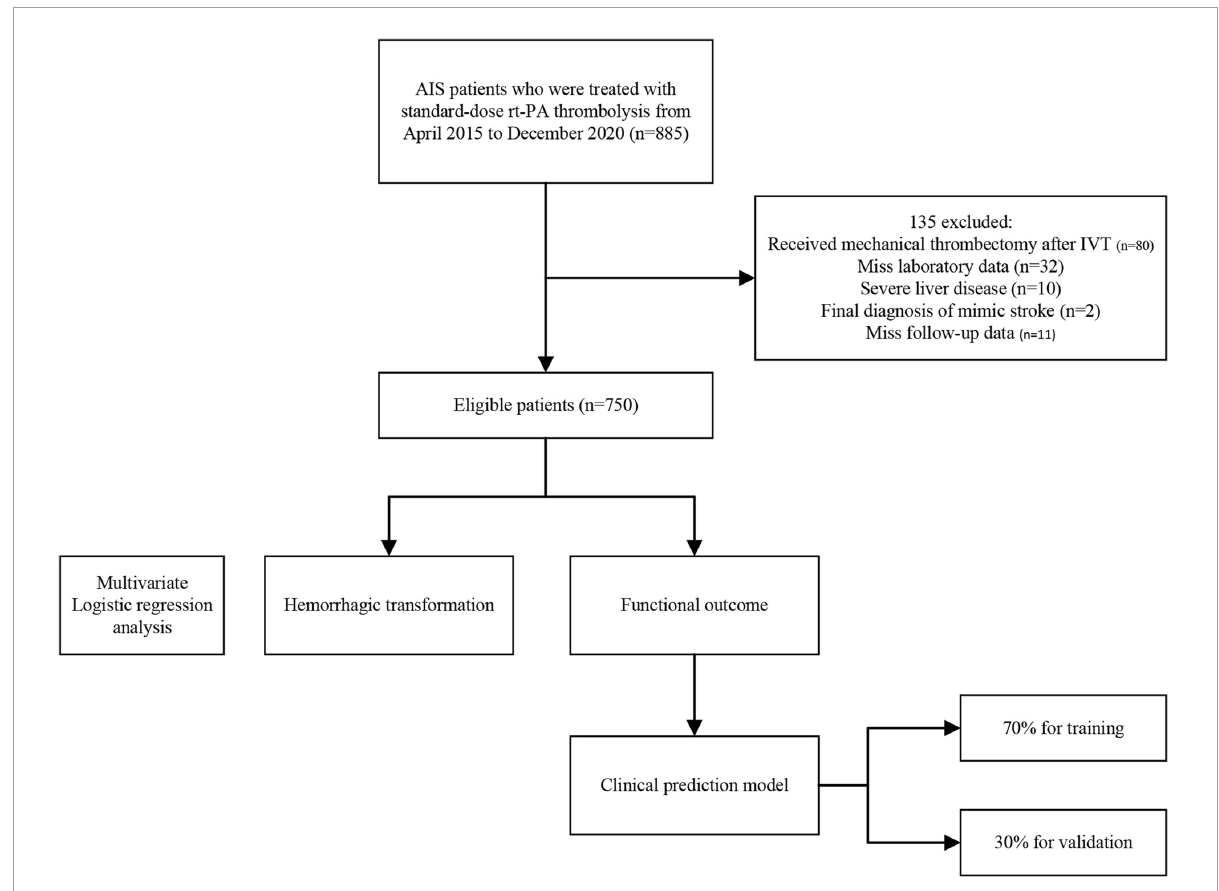
FIGURE1 The flowchart of patient selection.